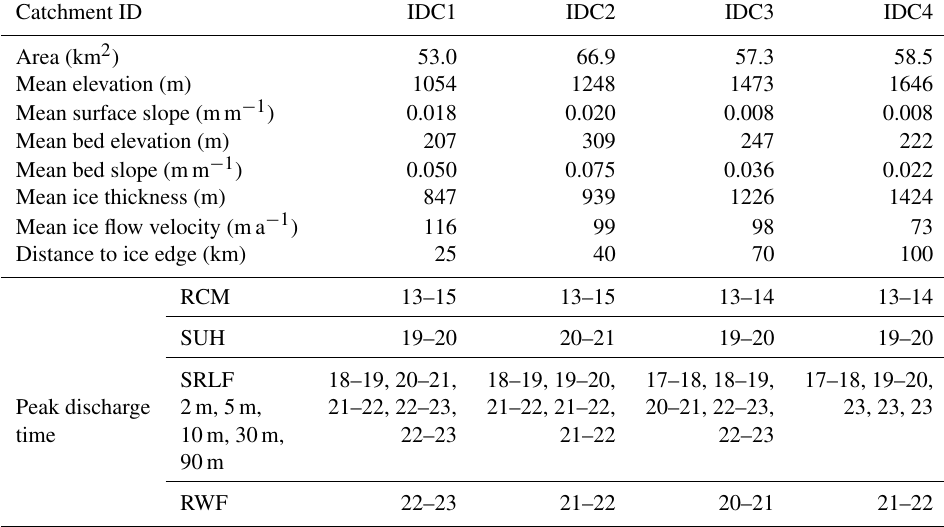
Table 2. Summary of four study